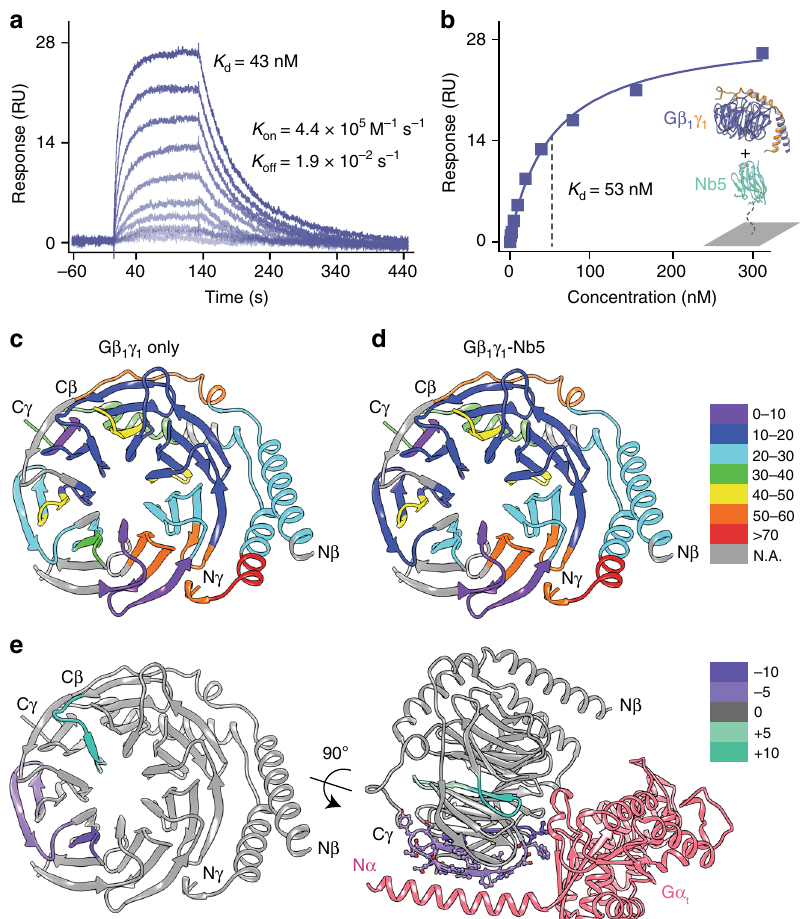
Fig. 2 Kinetic pro fi ling and hydrogen-deuterium exchange (HDX) of the G β 1 γ 1 -Nb5 complex. Binding of G β 1 γ 1 to immobilized Nb5 in SPR equilibrium binding experiments. Association of the G β 1 γ 1 dimer with Nb5 was investigated by single-cycle kinetics ( a ) and af fi nity based analysis ( b ). Resonance signals are indicated in response units (RU). The determined dissociation constants ( K d ) and kinetic parameters ( K on and K off ) are shown as insets. HDX of the G β 1 γ 1 dimer without ( c ) and with ( d ) Nb5 is shown with all the identi fi ed peptides colored by their percentage of deuterium exchange. e Differential HDX data mapped into the crystal structure of G β 1 γ 1 (PDB ID: 5KDO) indicate peptides with increased (greencyan) and reduced (purple) deuterium incorporation upon Nb5 binding (left). Interestingly, G β 1 γ 1 peptides that revealed changes in their solvent accessibility during HDX analyses displayed a partial interface with the G α subunit (right, pink). The G α subunit was omitted from the left panel for